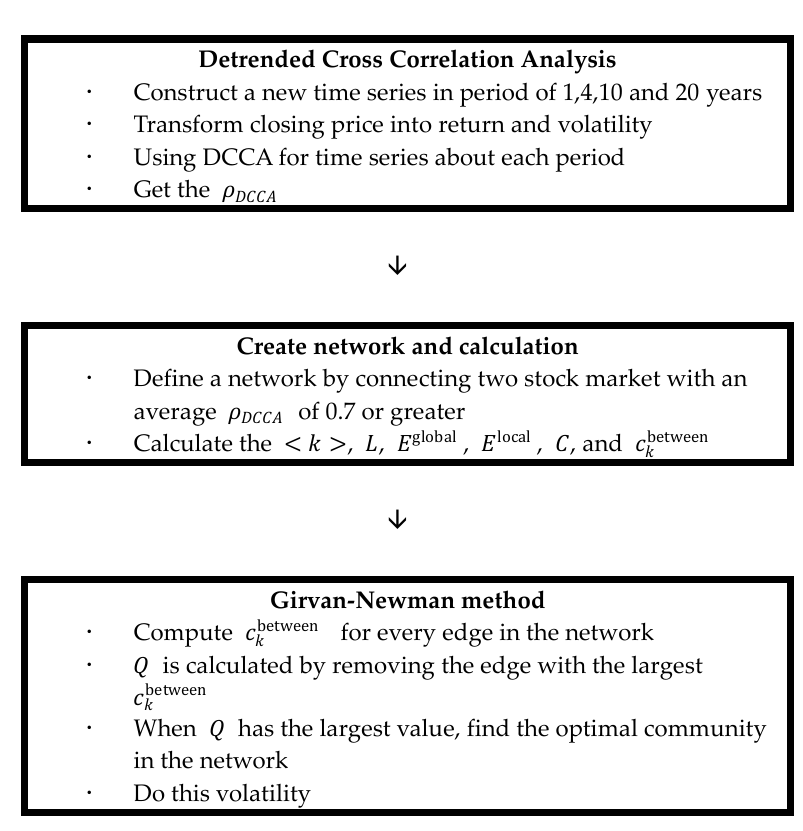
Figure 2. Schematic diagram of detrended cross correlation analysis and network analysis. 218